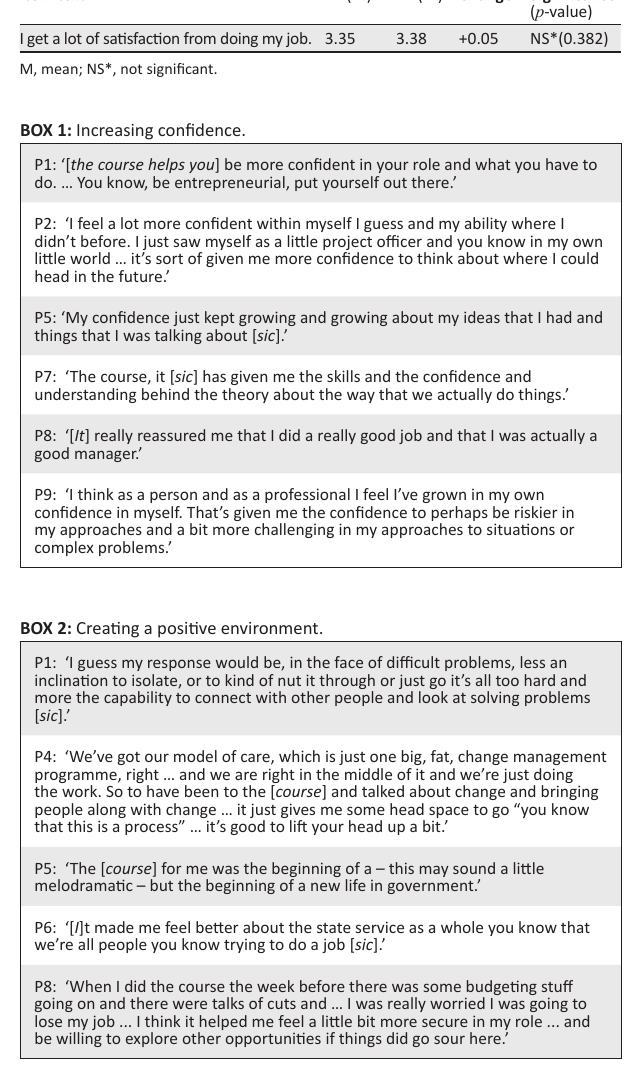
TABLE 8: Job orientation. Item